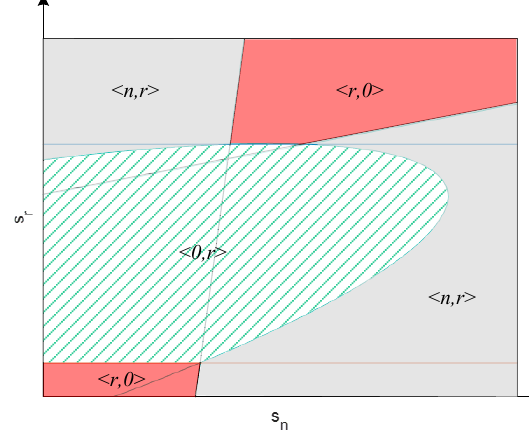
Figure 12. The optimal scenario distribution of the remanufacturer.